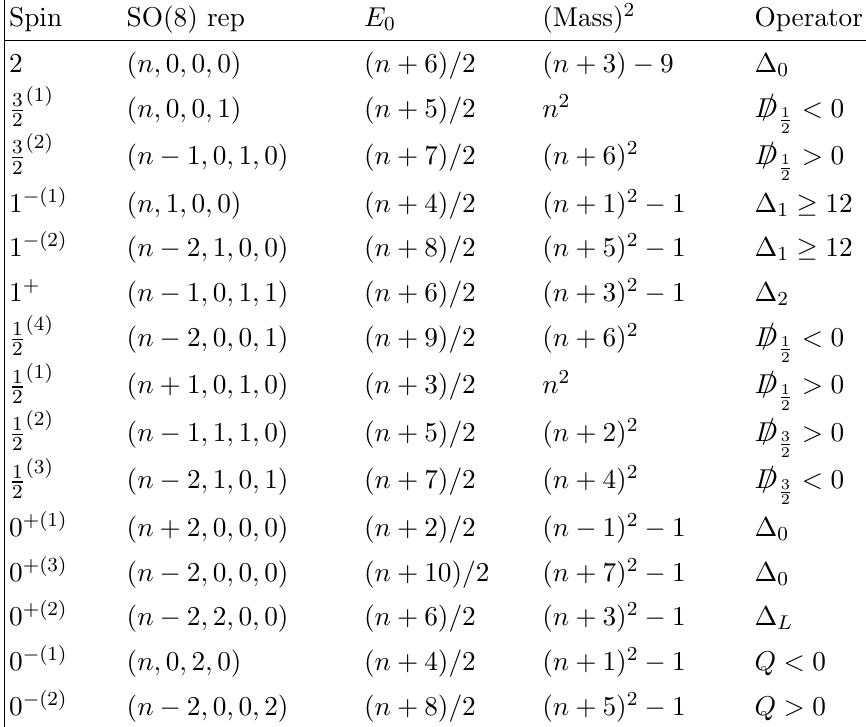
Table 4. The complete spectrum of particles on the round sphere compactification of eleven- dimensional supergravity. Each integer n gives an entire supermultiplet of particles. For the linear operators the positive and negative part of the spectrum is associated with different towers as indicated by the inequality